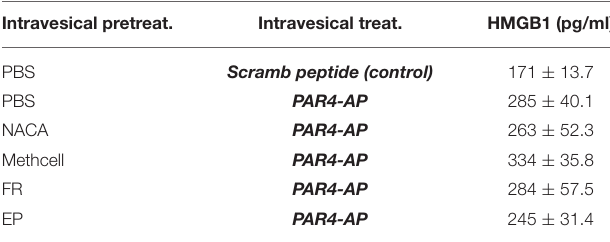
TABLE 1 | HMGB1 concentration in intravesical fluid after each treatment. Mean ± SEM. N = 6 per group. Intravesical